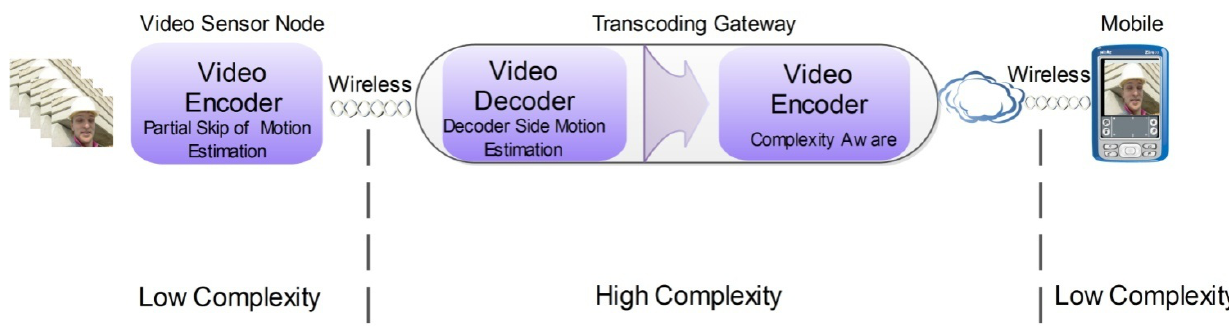
Figure 5. Transcoding